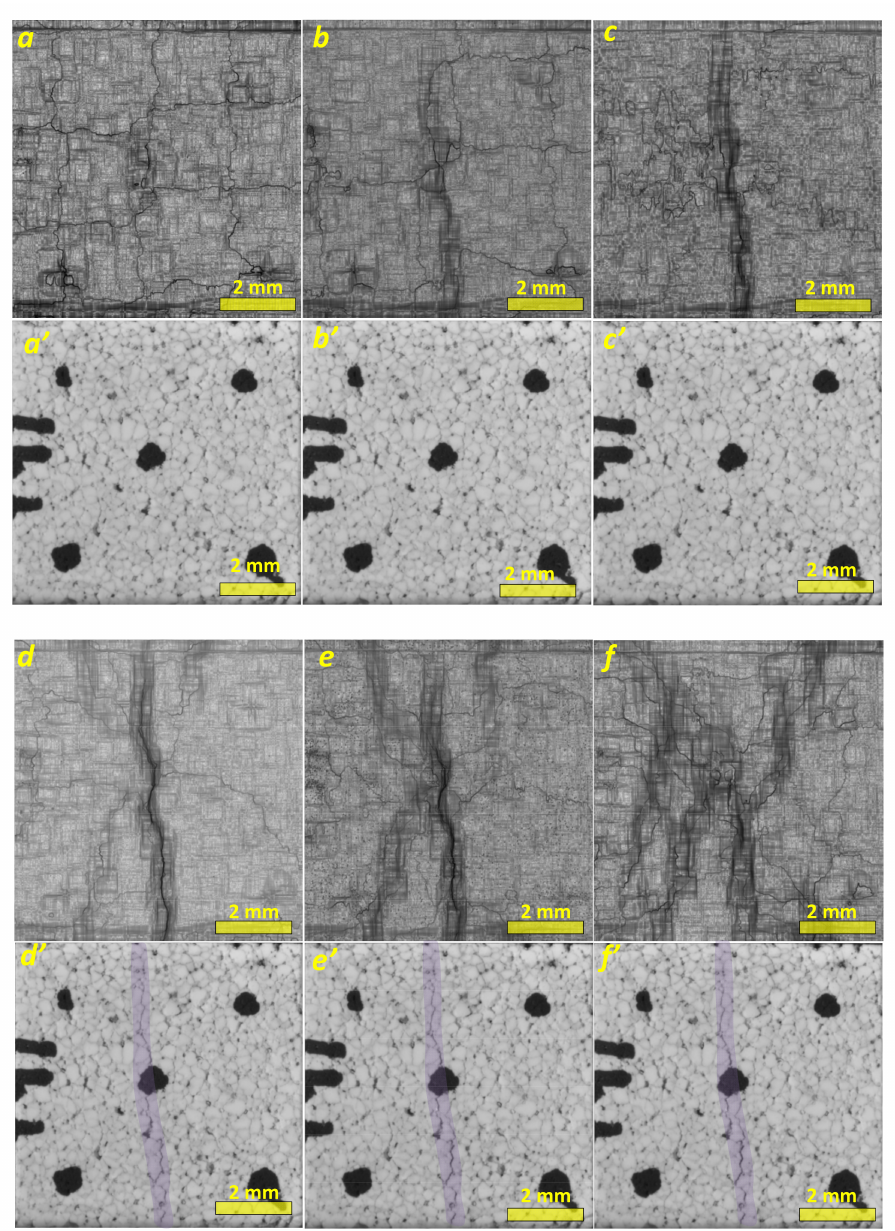
Figure 4. In situ strain localization maps ( a – f ) and corresponding optical macrographs of segmented porous alumina ( a’ – f’ ), at strain levels as follows: ε = 0.0012, ∆ ε = 0.0012 ( a ); ε = 0.0024, ∆ ε = 0.0024 ( b ); ε = 0.0042, ∆ ε = 0.0042 ( c ); ε = 0.0072, ∆ ε = 0.006 ( d ); ε = 0.0102, ∆ ε = 0.006 ( e ); and ε = 0.0144, ∆ ε = 0.006 ( f ). Black marks were drawn to better focus the